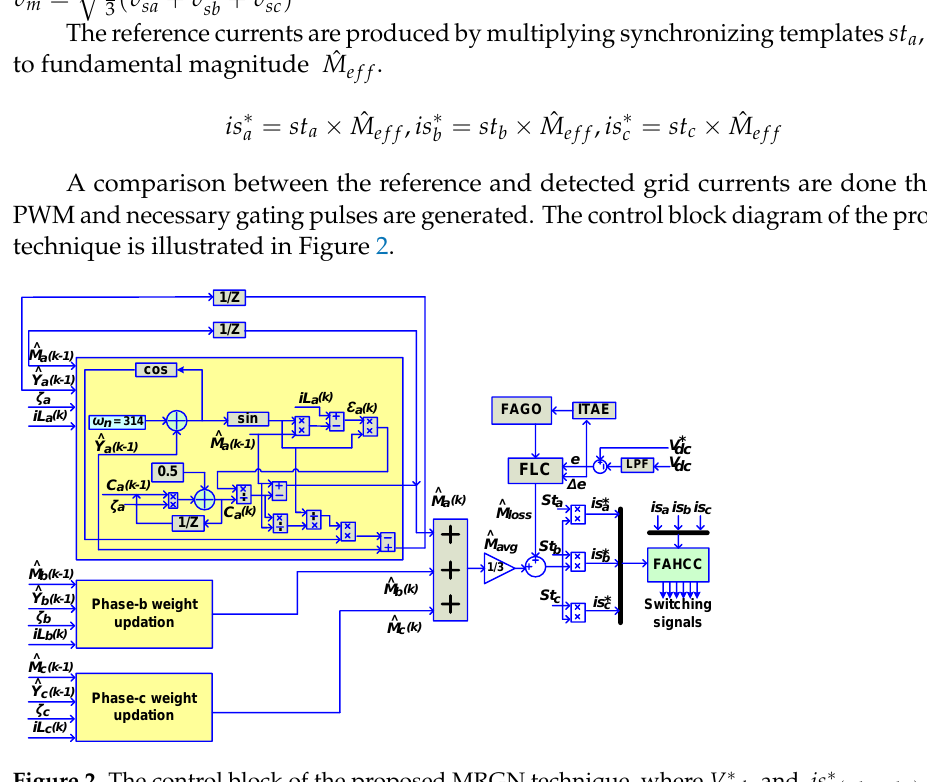
is are the ( , ) a bandc